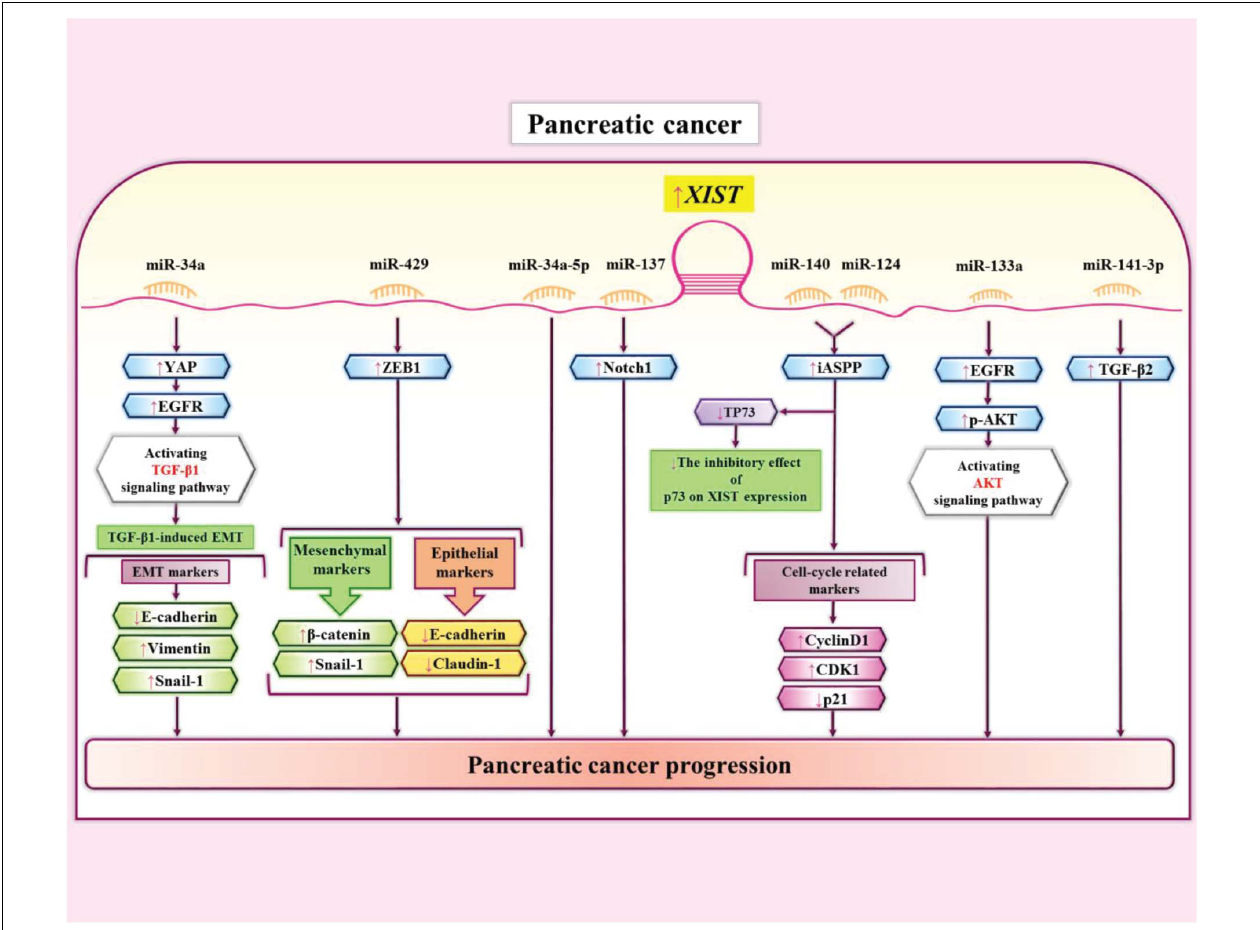
FIGURE 4 | The interaction between XIST and miRNAs as well as their targets in pancreatic cancer cells (Liang et al., 2017; Wei et al., 2017; Sun et al., 2018; Shen et al., 2019; Sun and Zhang, 2019; Liu et al., 2020; Zou et al., 2020). XIST interaction with miR-140 and miR-124 increases expression of iASPP and promotes growth of pancreatic cancer cells (Liang et al., 2017). XIST also enhances expression of TGF- β 2 through sequestering miR-141-3p. This interaction enhances invasiveness of pancreatic cancer cells (Sun and Zhang,